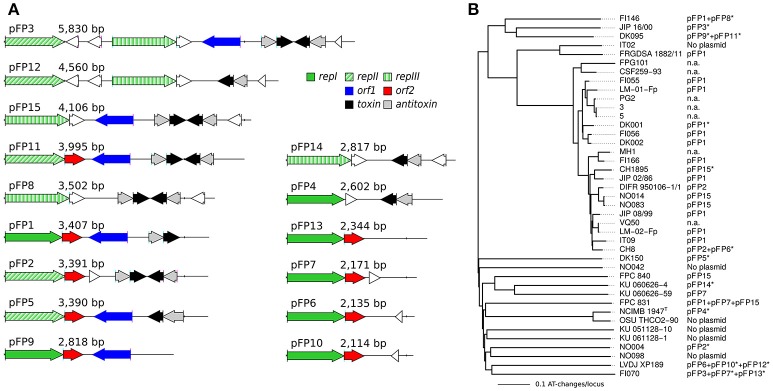
Plasmids found in our collection of isolates. (A) Physical maps of the 15 types of plasmids (pFP1 to pFP15) are ordered by length. Colors indicate the main different types of genes (see inset legend), pseudogenes, and unknown short genes are represented in white. Three types of rep genes have been distinguished based on the important divergence of amino-acid sequences. (B) Distribution of the 15 types of plasmids across the isolates. The Neighbor-Joining tree obtained on whole-genome MLST profiles is used here. n.a. stands for no data available. Asterisks (*) indicate the representatives that served to illustrate the different types of plasmids.